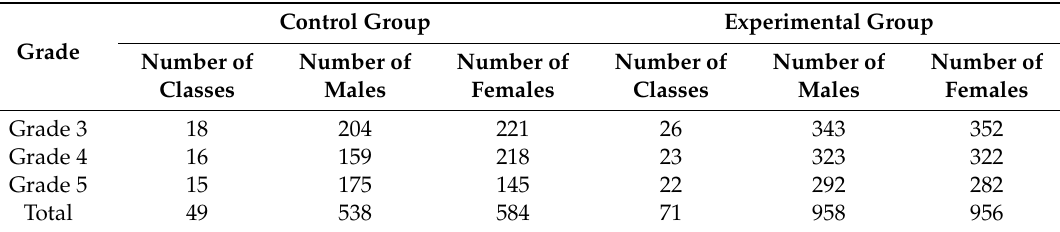
Table 1. Sample subject